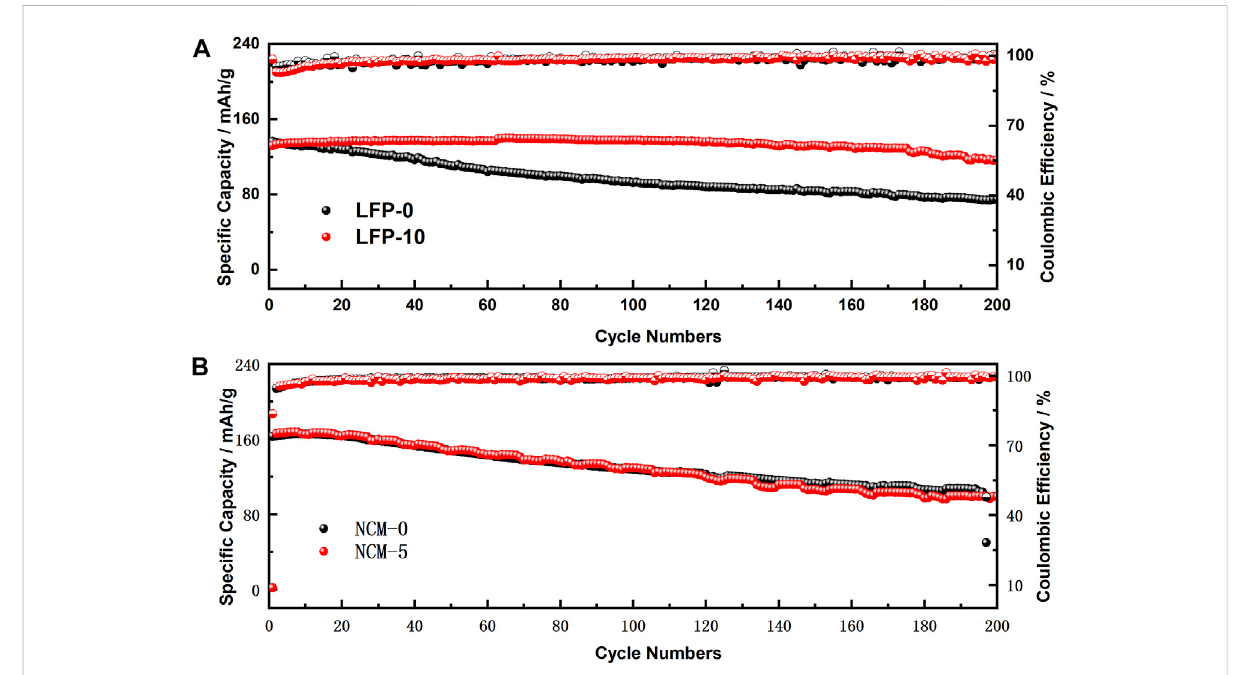
FIGURE 7 Long cycle performance of all samples: (A) LiFePO 4 ; (B) NCM811.